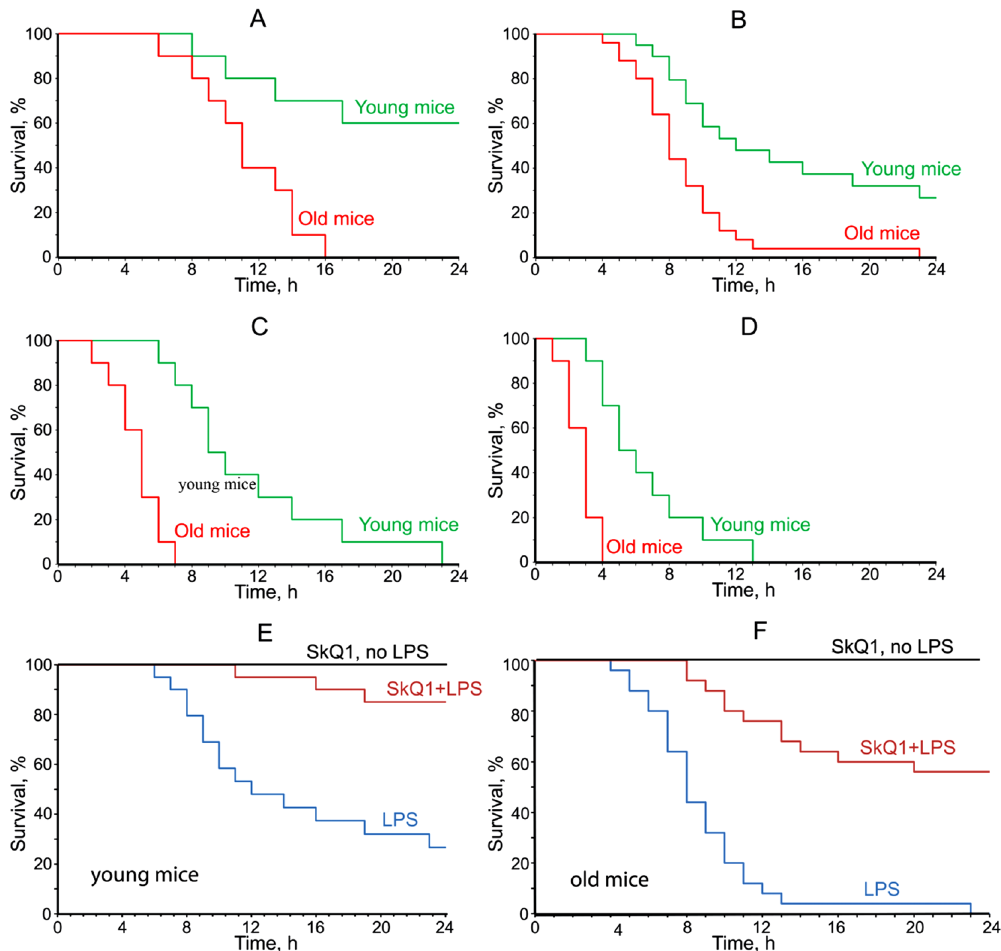
Figure 2. SkQ1 prevents lethal toxicity of bacterial lipopolysaccharide (LPS). LPS at doses10 mg/kg ( A ), 20 mg/kg ( B,E,F ), 30 mg/kg ( C ) or 40 mg/kg, ( D ) was injected intravenously. SkQ1 (1.5 mmol/kg/day) was administered intraperitoneally for 5 days. Here and below Young (3 months) and old (28 months) C57Bl6 mice were used. Kaplan–Meier survival curves are shown. The number of mice in each group treated with LPS was 25, and in groups without LPS,